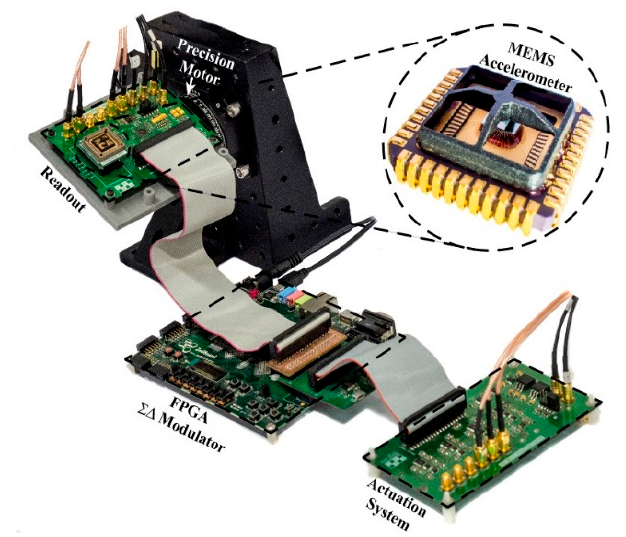
Figure 3. Experimental